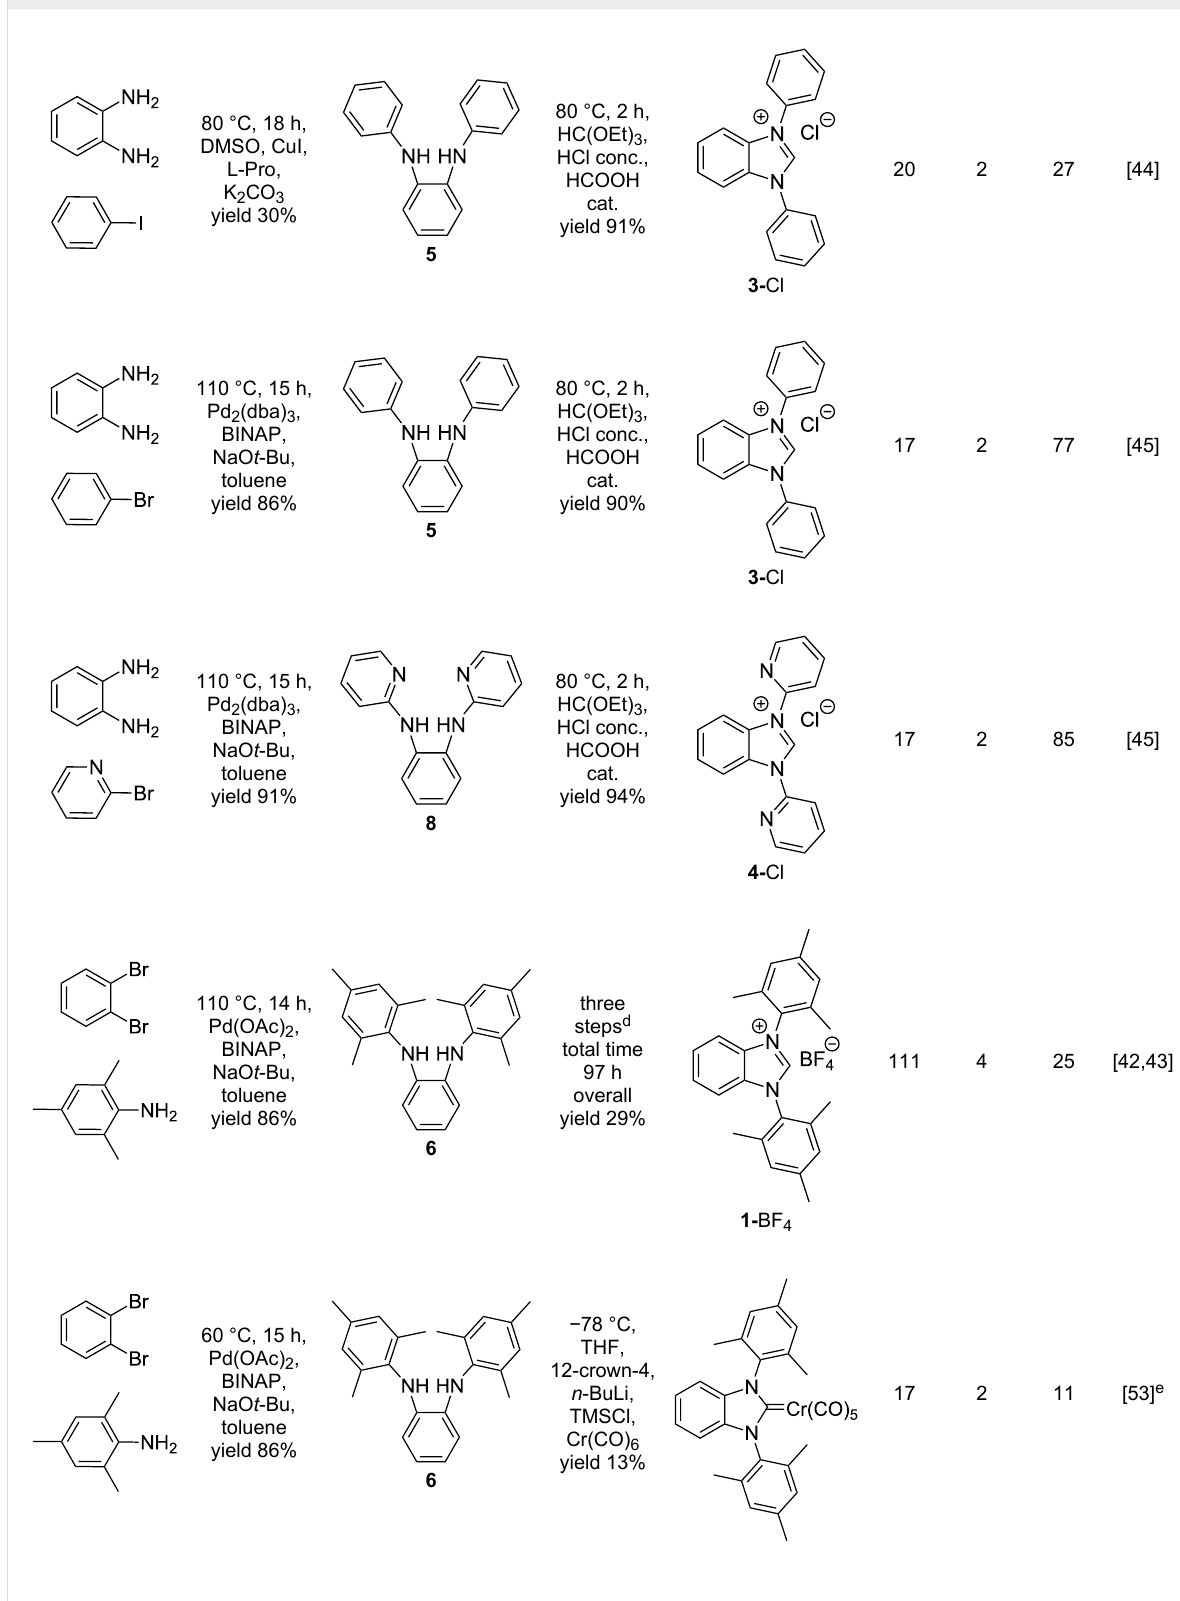
Table 1: Comparison of various preparations of the benzannulated NHCs: 1 -Cl, 2 -Cl, 3 -Cl and 4 -Cl, and of 1 -BF 4 , 3 -BF 4 and 4 -BF 4 .